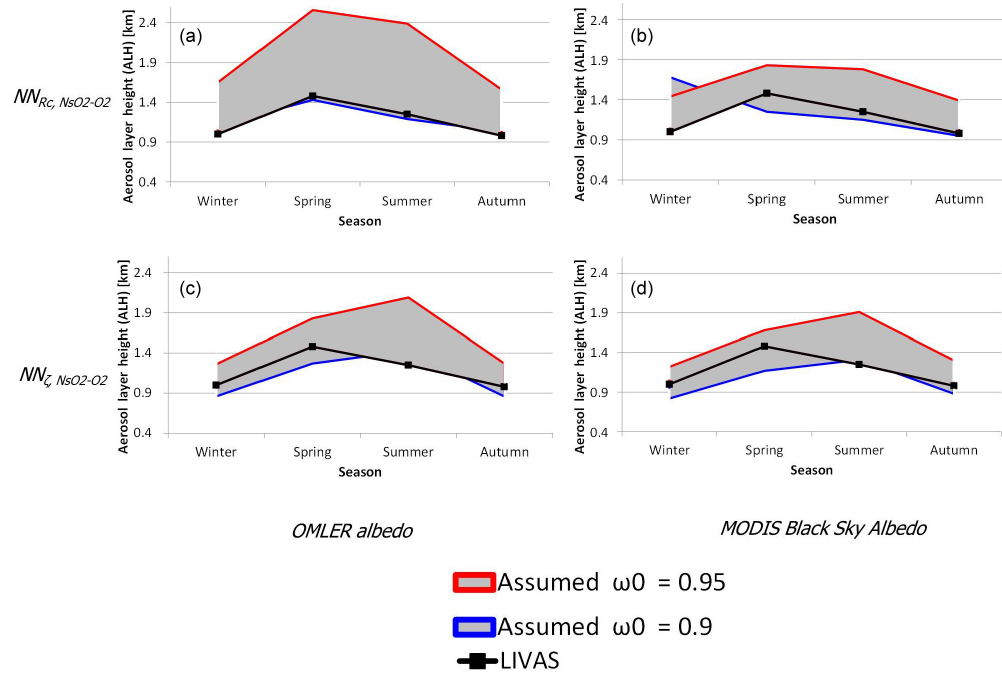
Figure 17. Comparison of the average of the OMI ALH retrievals obtained over scenes with collocated MODIS τ ≥ 1 . 0, with the LIVAS ALH climatology database. The retrievals are achieved over north-east Asia for cloud-free scenes, over 3 years, 2005–2007, and for the four seasons. OMI and MODIS black-sky surface albedo is alternatively considered. The two NN OMI ALH algorithms are used (see Sect. 5.1): NN R based on OMI R c (475nm) and NN τ,N s based on MODIS τ (550nm). A temperature correction is applied to the OMI c ,N s O2 − O2 O2 − O2 N s prior to the retrievals (see Sect. 6.1): (a) NN R algorithm and OMLER surface albedo, (b) NN R O 2 − O 2 c ,N s O2 − O2 MODIS black-sky surface albedo, (c) NN τ,N s algorithm, and OMLER surface albedo and (d) NN τ,N s O2 − O2 black-sky surface